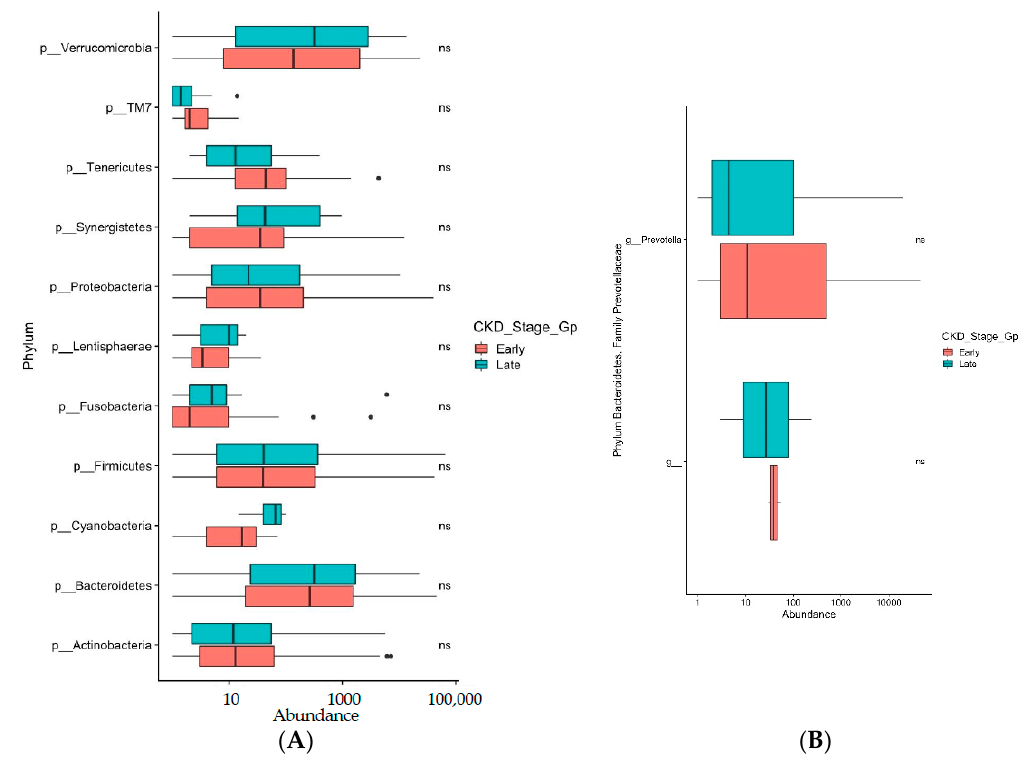
Figure 5. ( A ): Box and whiskers plots display a relative abundance of genera Ruminococcus and Faecalibacterium between early and late CKD groups . ns denotes non significance. ( B ): Box and whiskers plots display relative abundance of genus Bifidobacterium between early and late CKD groups . ns denotes non significance. ( C ): Box and whiskers plots display rela- tive abundance of genus Bacteroides between early and late CKD groups . ( D ): Box and whiskers plots display relative abundance of genus Akkermansia between early and late CKD groups . ns denotes non significance.